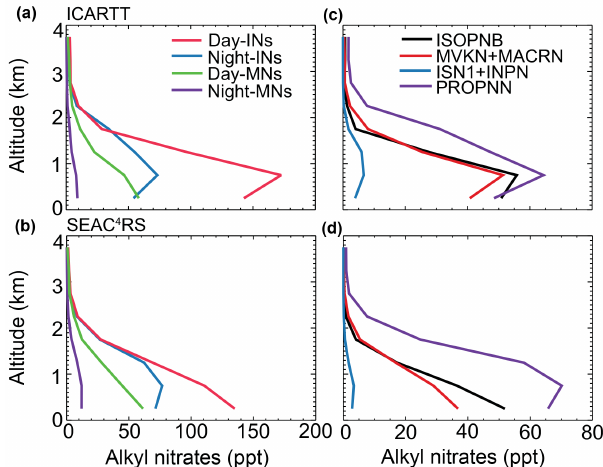
Figure 5. Mean vertical profiles of modeled alkyl nitrates from iso- prene and monoterpene oxidation (a, b) and major isoprene nitrate species (c, d) during ICARTT (a, c) and SEAC 4 RS (b, d) from AM3 with hydrolysis of